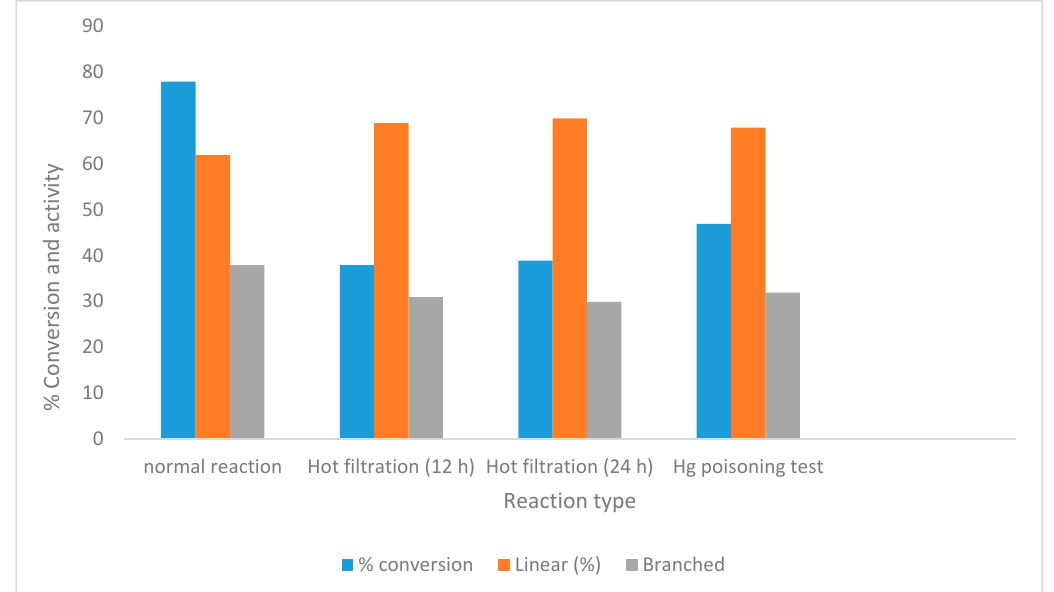
Figure 5. A graph showing the comparison between the control reaction, hot filtration and mercury poisoning experiments.